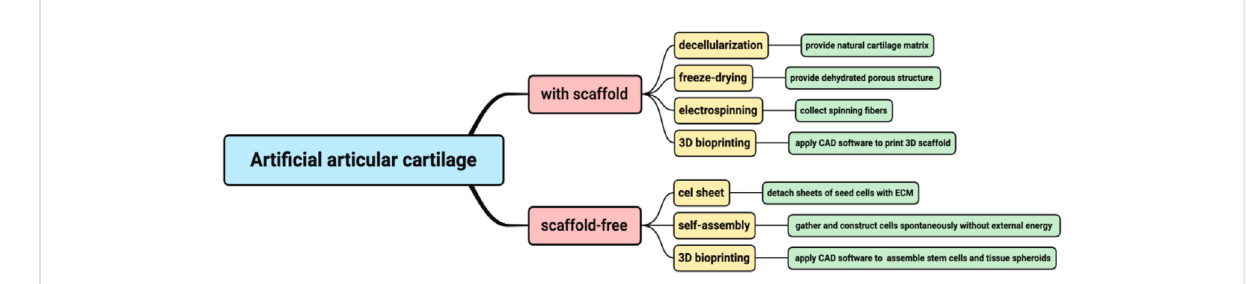
FIGURE 1 Brief introduction of the tissue engineering techniques for arti fi cial